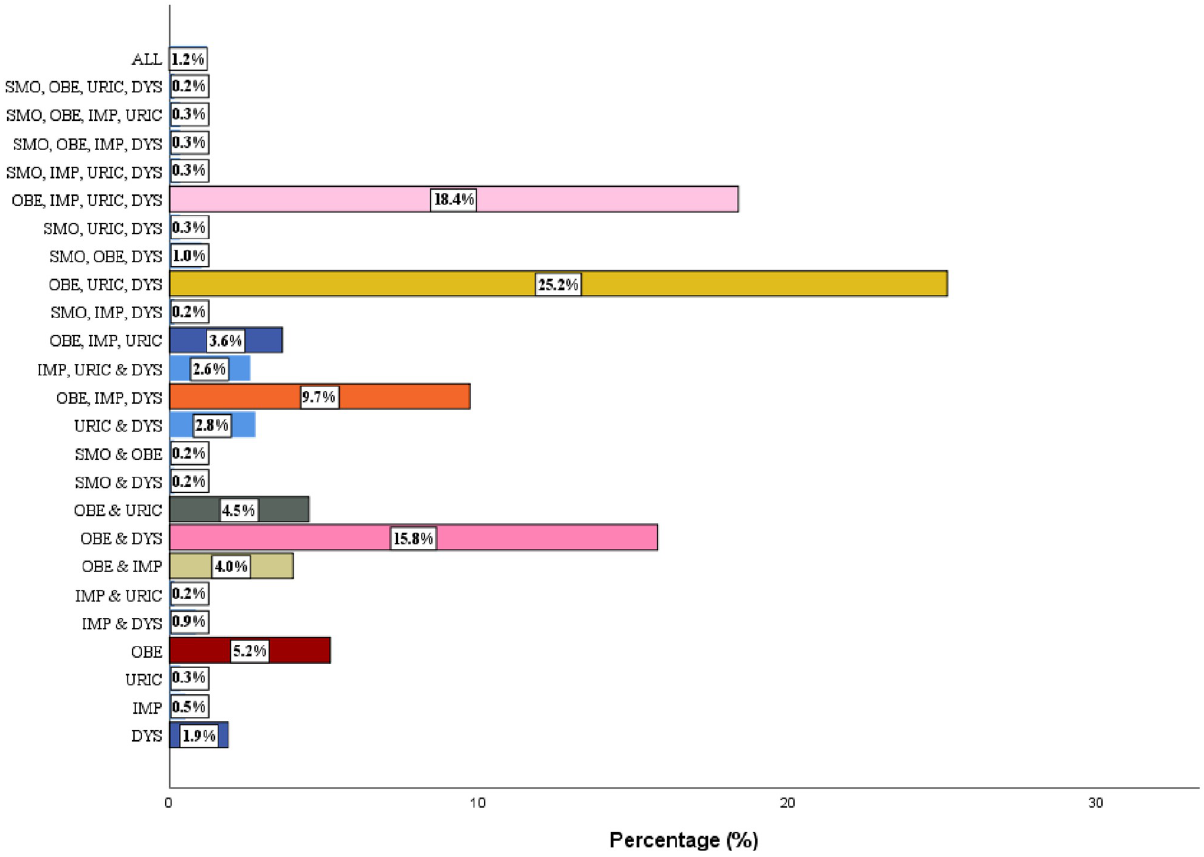
Fig 5. Some common cardiovascular risk factor combinations in the study